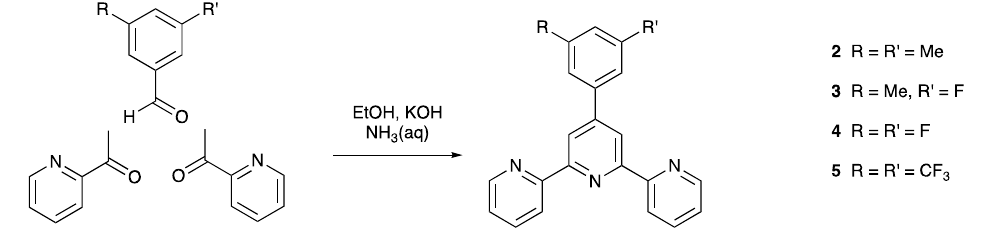
Figure 1. Aromatic regions of the 1 H NMR spectra (500 MHz, CDCl 3 ) of compounds 2–5 with atom labeling as shown in Scheme 1. * = residual CHCl 3 . Chemical shifts in δ /